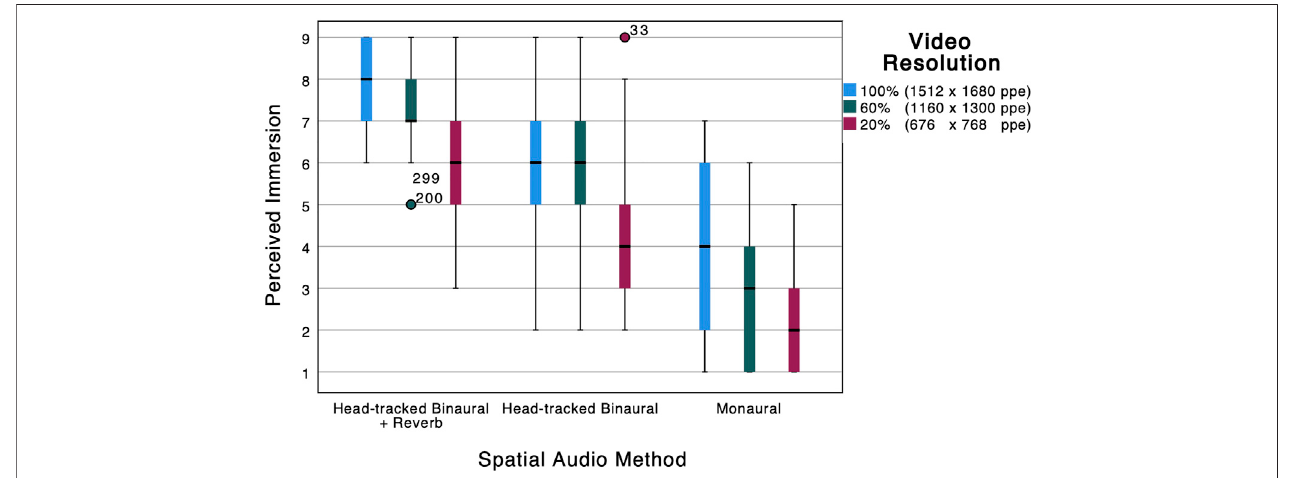
FIGURE 3 | Box plot of perceived immersion against video resolution and spatial audio method.